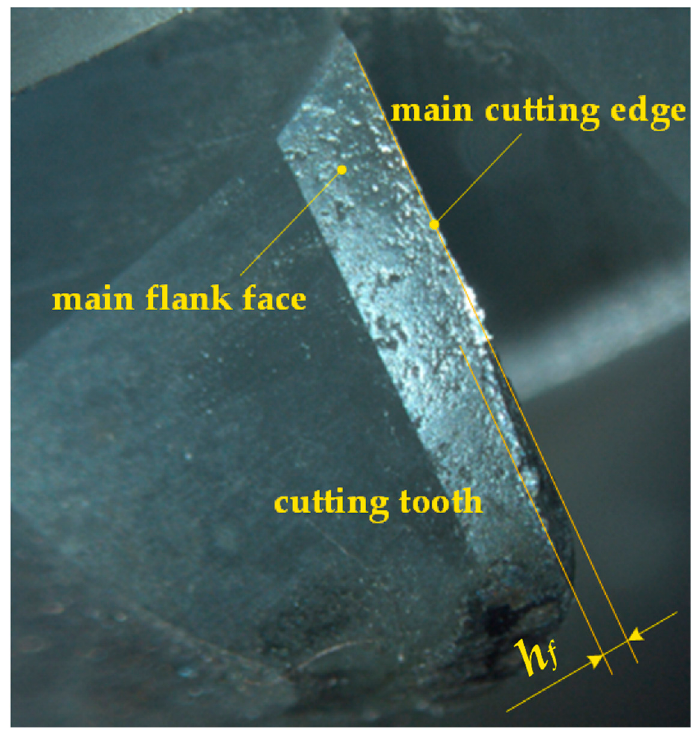
Figure 8. The wear zone location on the flank face of the ceramic end mill tooth and the h f area (land) to measure the quantified wear.